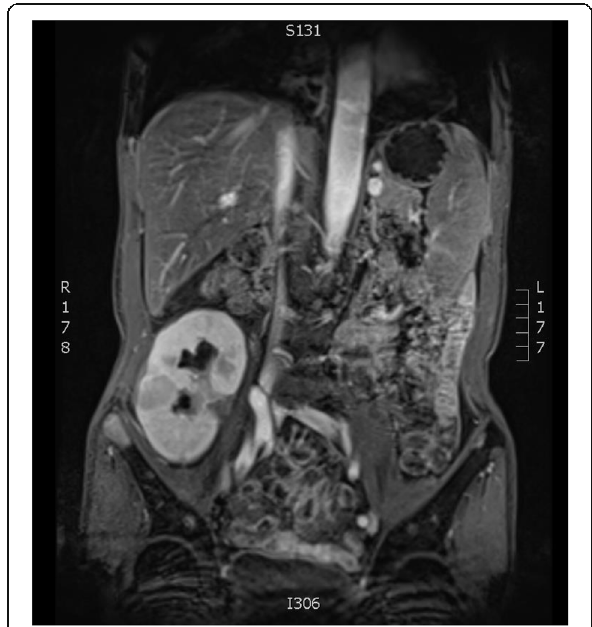
Fig. 1 Enhanced MRI demonstrated multiple, variably sized quasi- circular lesions with slightly short signal intensity on T1WI, slightly long signal intensity on T2WI, and high signal intensity on DWI. The larger size lesion was about 4.66 cm by 3.10 cm